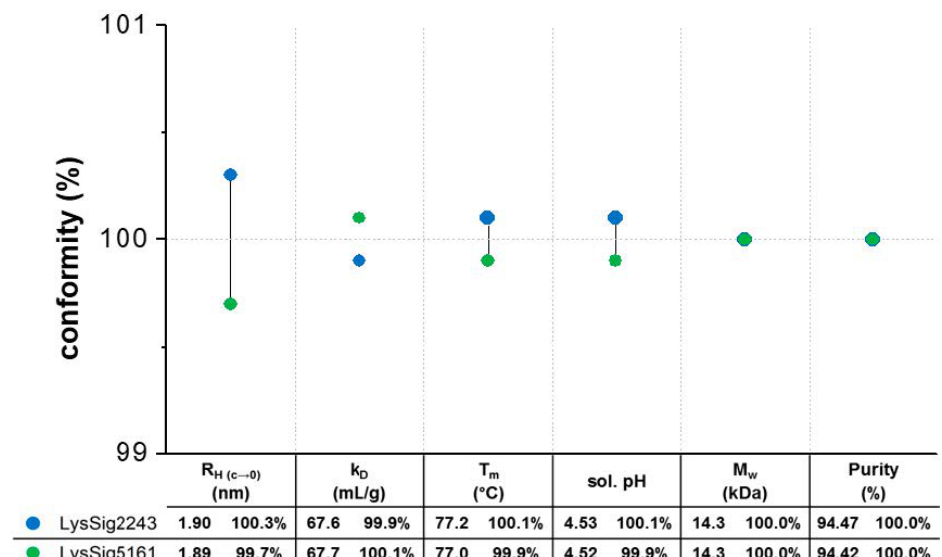
Figure 3. Batch conformity profile to evaluate the batch-to-batch variations: two lysozyme batches (blue spheres: LysSig2243 and green spheres: LysSig5161) were investigated in terms of their hydrodynamic (dynamic light scattering (DLS): hydrody- namic radii ( R H(c → 0) ) and diffusion self-interaction parameter ( k D )), thermodynamic (intrinsic fluorescence spectroscopy (IFS): denaturation temperature ( T m )), and physicochemical properties (solution pH and LC-MS: molecular weight ( M w ) and purity). The percentage conformity calculations were based on the averaged values of both